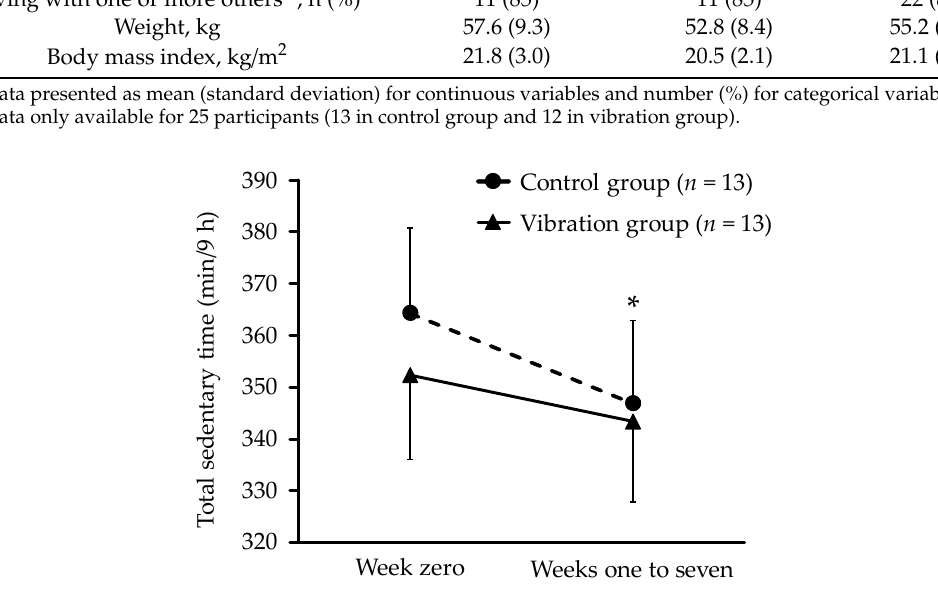
Figure 3. Change in sedentary time from week zero to weeks one to seven. Each data point represents mean value for all participants, with missing data replaced by baseline observation carried forward. Error bars indicate standard error. * p < 0.05 for within-group differences.